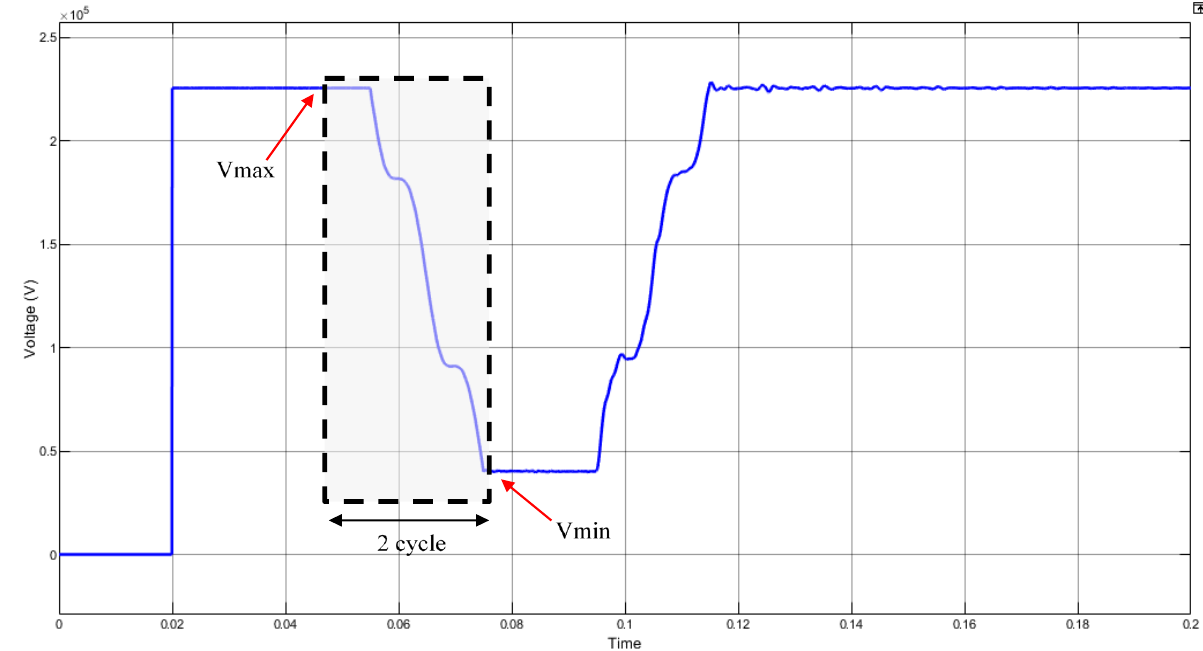
Appl. Sci. 2021 , 11 , x FOR PEER REVIEW Figure 8. Voltage dip criteria for fault causes. Figure 8. Voltage dip criteria for fault causes.